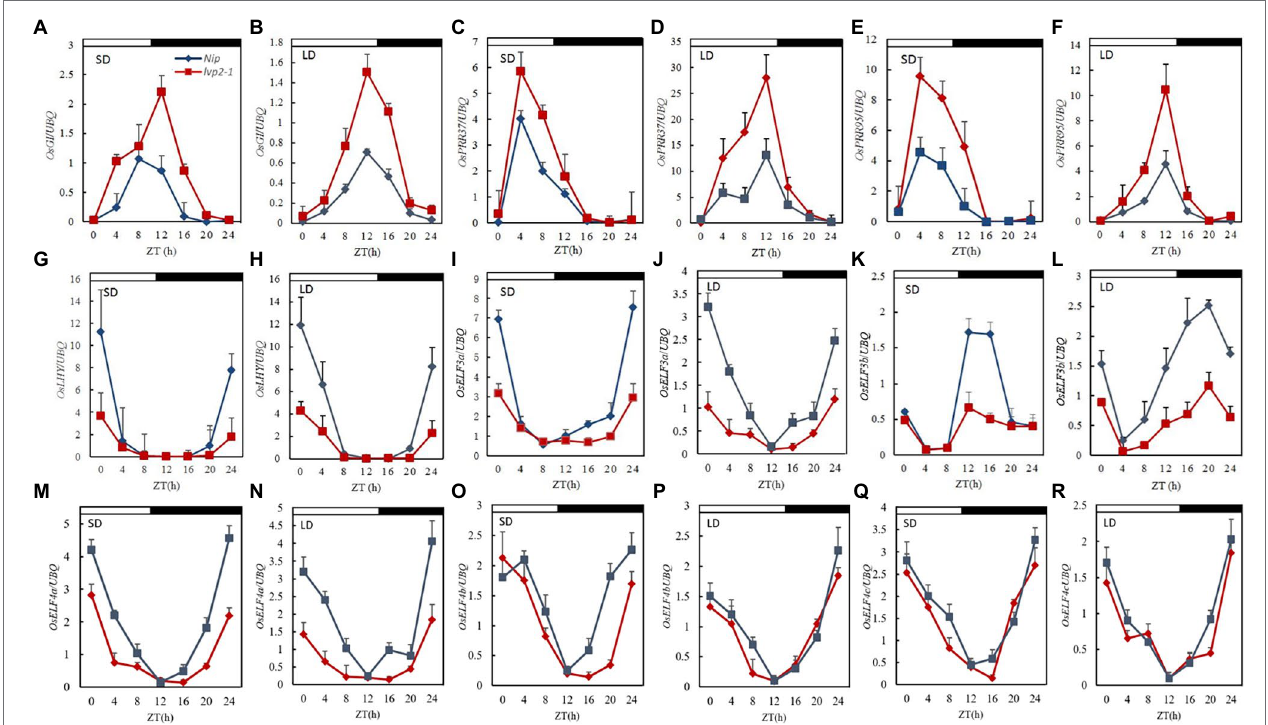
FIGURE 4 | Diurnal expression of clock-associated genes in WT and lvp2-1 under both SD and LD conditions. Diurnal expression patterns of OsGI (A,B) , OsPRR37 (C,D) , OsPRR95 (E,F) , OsLHY (G,H) , OsELF3a (I,J) OsELF3b (K,L) , OsELF4a (M,N) , OsELF4b (O,P) , and OsELF4c (Q,R) in Nipponbare (blue diamonds) and lvp2-1 mutant (red squares) plants in SD and LD detected by qRT-PCR analysis. Rice leaves were collected at the indicated time points from 35- and 70-day-old plants grown under LD (14 h light) and SD (10 h light) conditions, respectively. The expression levels are relative to the UBQ mRNA. Values and error bars are the mean and SD of three replicates. The white bars and black bars at the top represent the light and dark periods, respectively. Nip, Nipponbare; ZT, Zeitgeber